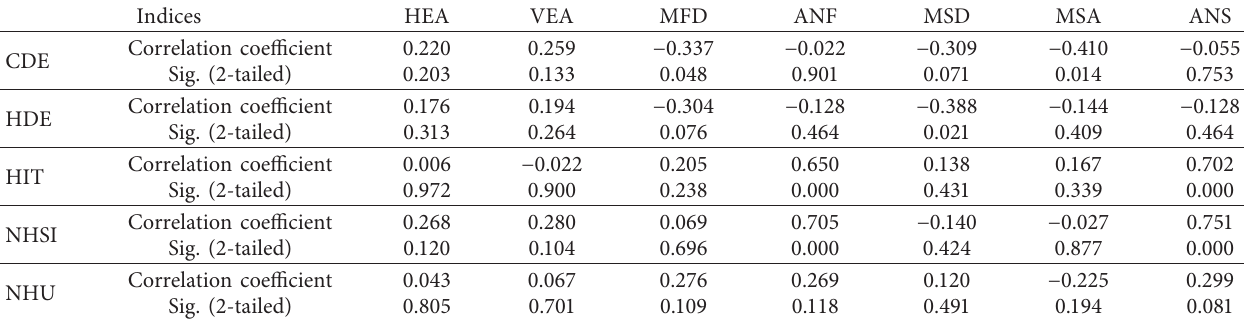
Table 8: Correlations between the indices of hazard perception and eye movement.